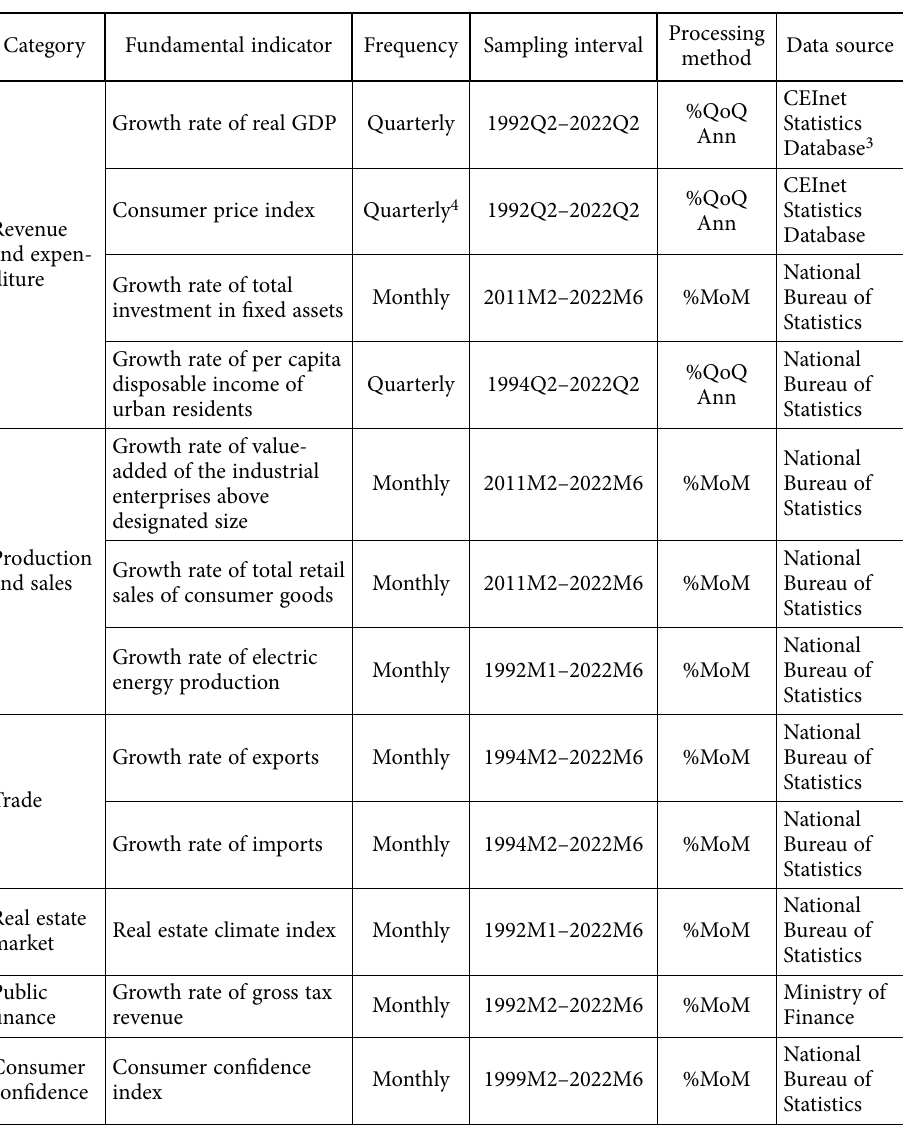
Table 1. Summary of fundamental